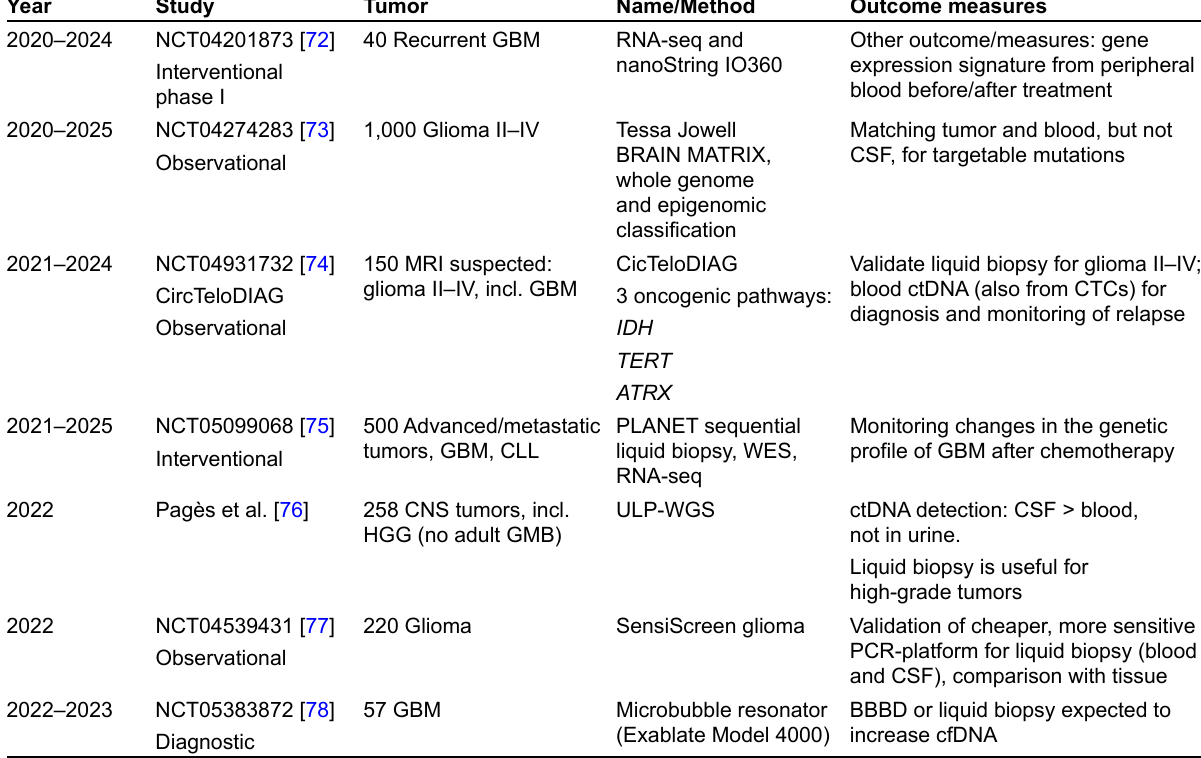
Explor Target Antitumor Ther. 2023;4:28–41 |